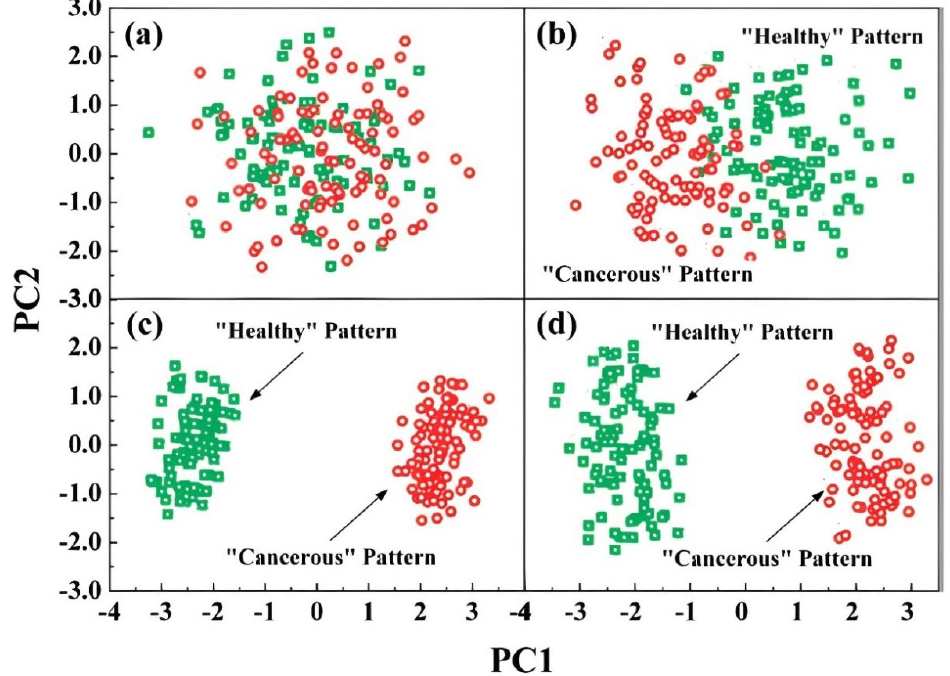
Figure 8. Principal components score plots upon exposure to simulated “healthy” and “cancerous” patterns at ( a ) 80% RH; ( b ) 10% RH; ( c ) 1% RH; and at ( d ) 80% RH and preconcentration of 50 times. Reprinted with permission from [47]. Copyright (2008) American Chemical Society.